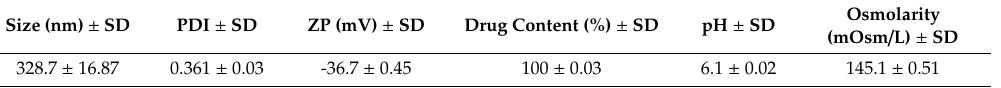
Table 4. Physico-chemical properties of optimized